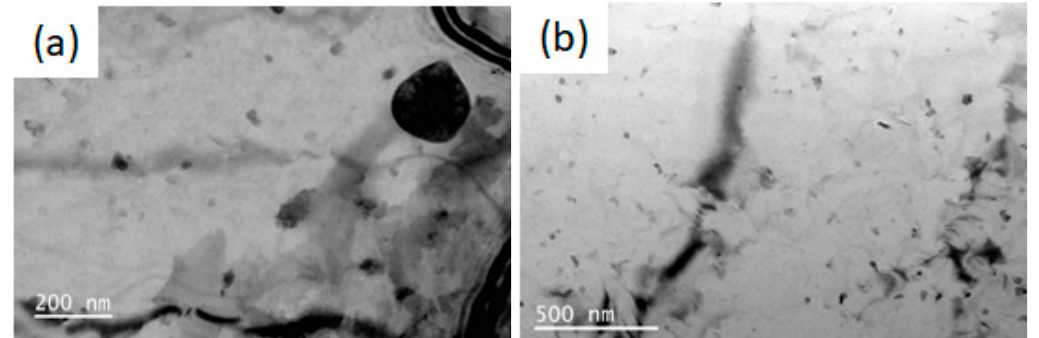
Figure 9. Microstructure characteristics of irradiated LT21: ( a ) thermal neutron fluence of 0.54 × 10 21 n/cm 2 ; ( b ) thermal neutron fluence of 2.38 × 10 22 n/cm 2 .